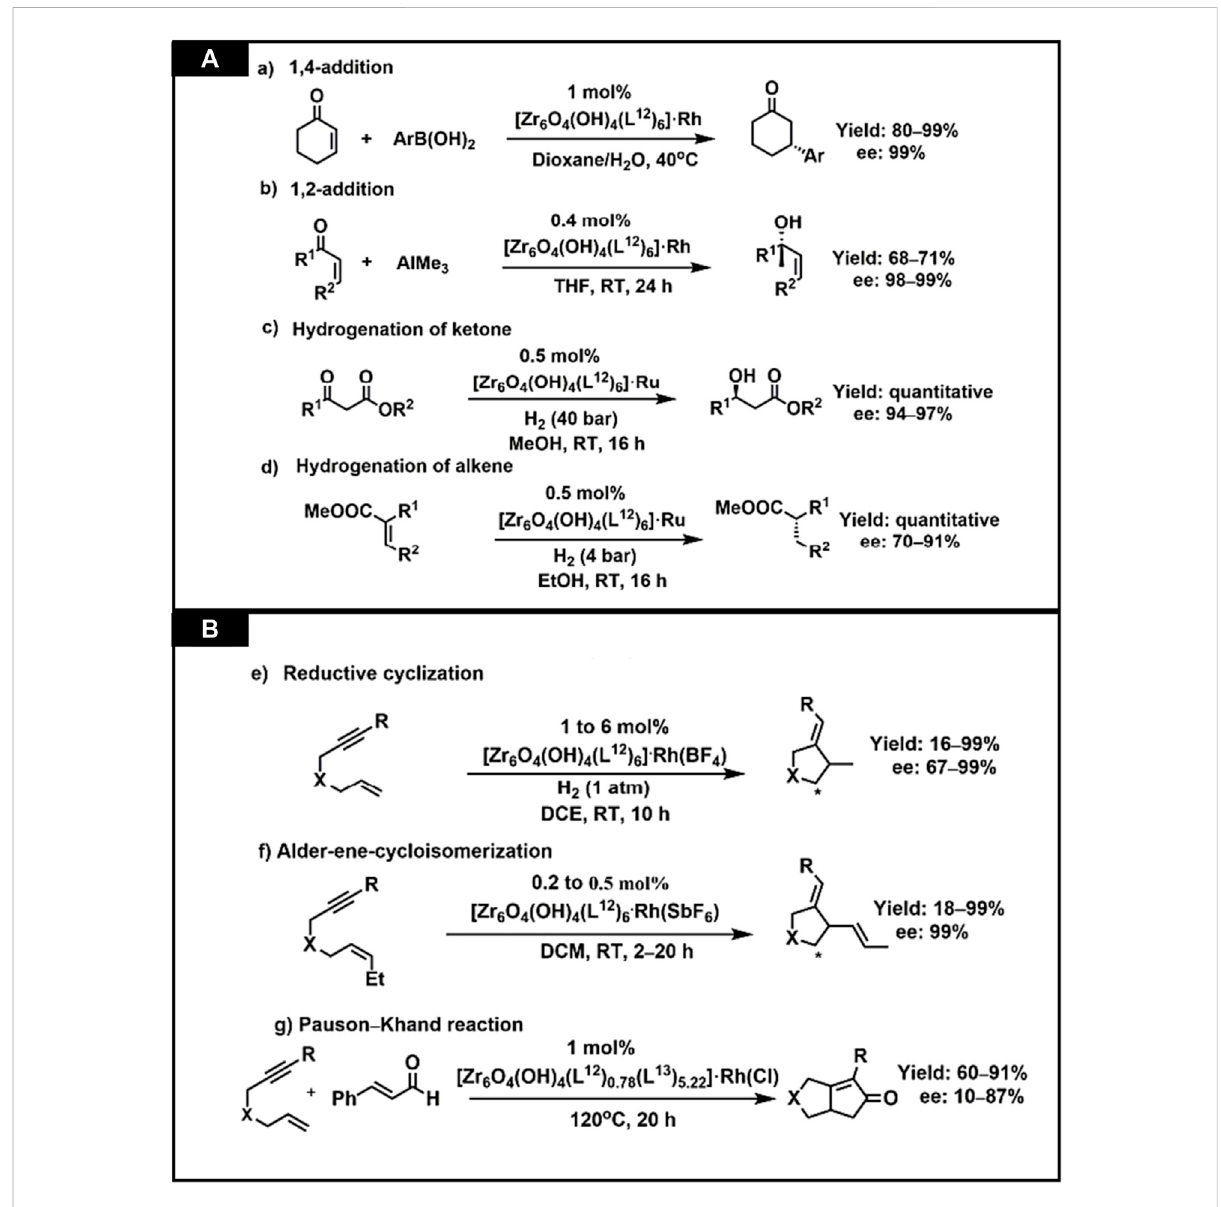
FIGURE 9 (A) BINAP-MOFs catalyzing asymmetric organic transformations (A) 1,4-additionreaction by MOF(25a), ( (B) 1,2-addition reaction by MOF (25a), (C) Hydrogenation of ketone byMOF (25b), ( (D) Hydrogenation of alkene by MOF (25b) (B) (E) Reductive cyclization of 1,6-enynes, (F) Alder-ene- cycloisomerizationof1,6-enynes, (G)